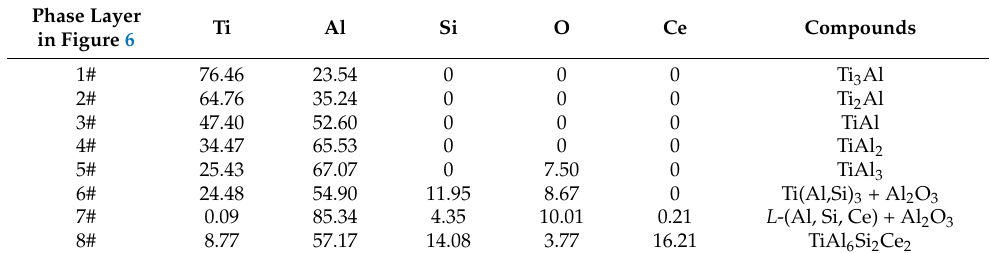
Table 1. EDS data and main compounds of each alloy phase layer.